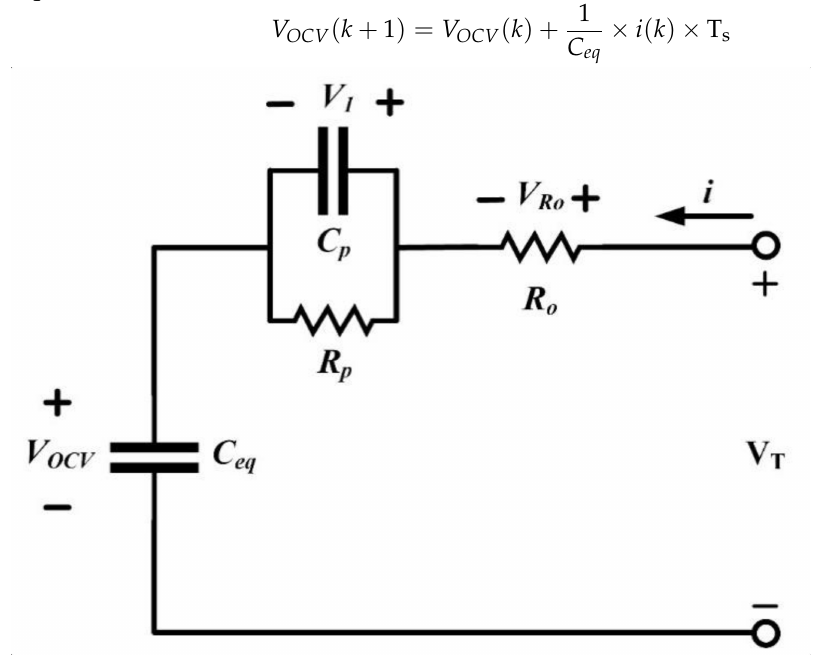
Figure 1. The utilized Thevenin equivalent circuit